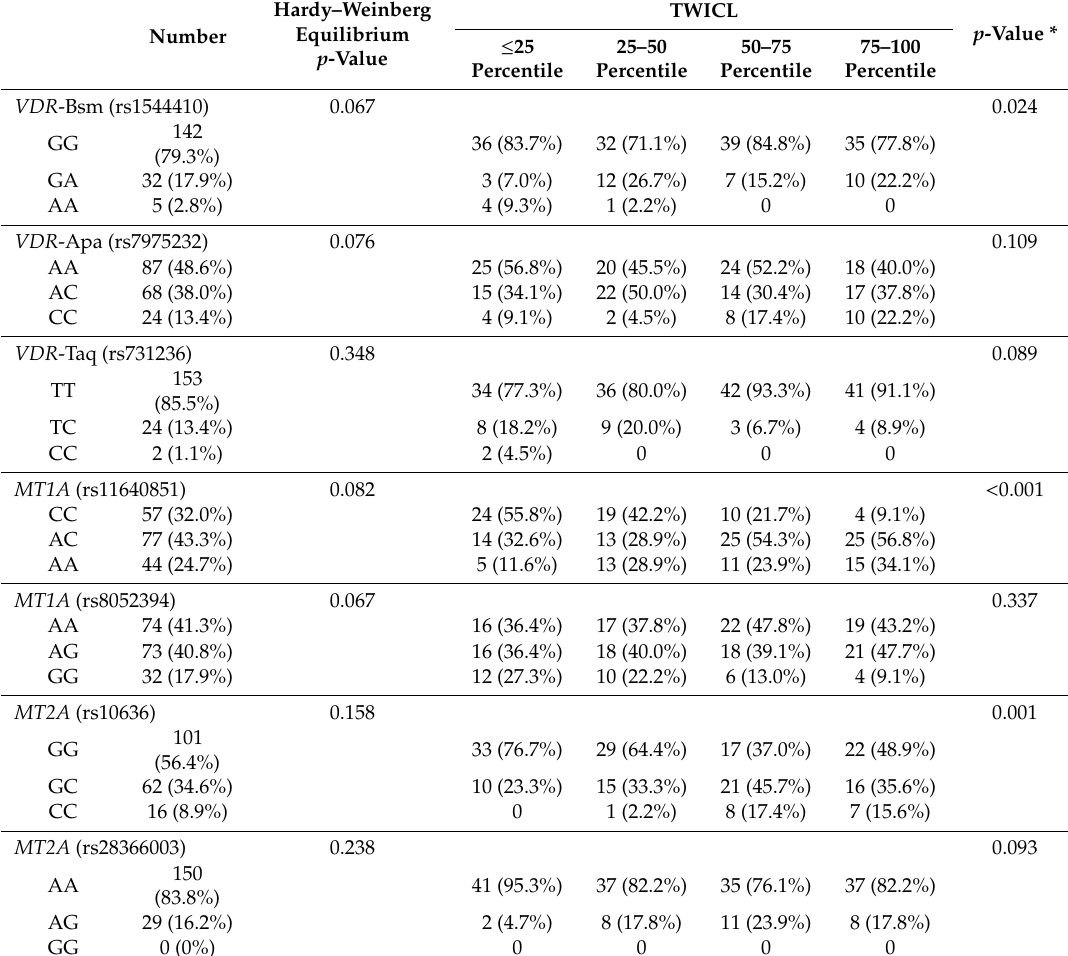
Table 3. SNP types in the lead